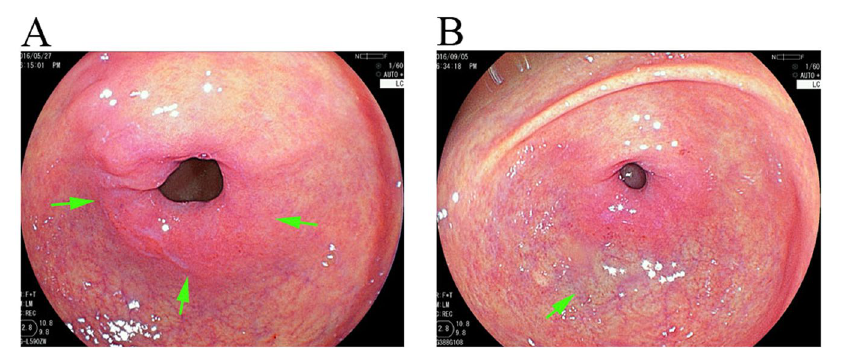
Figure 3. The purple pyloric ring ( A ) was manifested differently than the purple observed in the vessels ( B ).